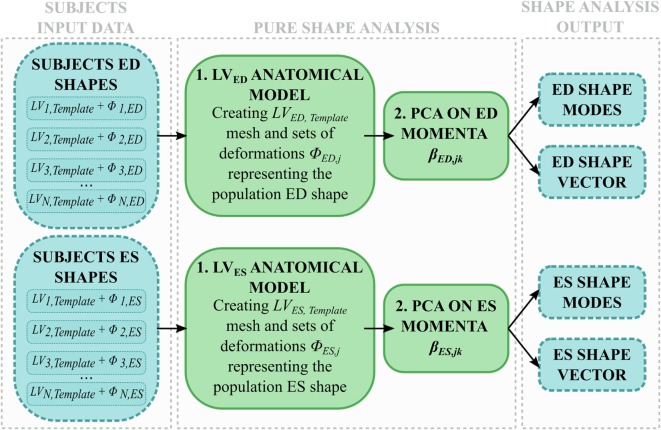
Shape analysis pipeline: for each subject, only ED and ES shapes are used to (1) build an anatomical model representing the LVED, LVES shape variability within the population; (2) the momenta vectors are decomposed with a PCA and the resulting shape modes and shape vector are analyzed.